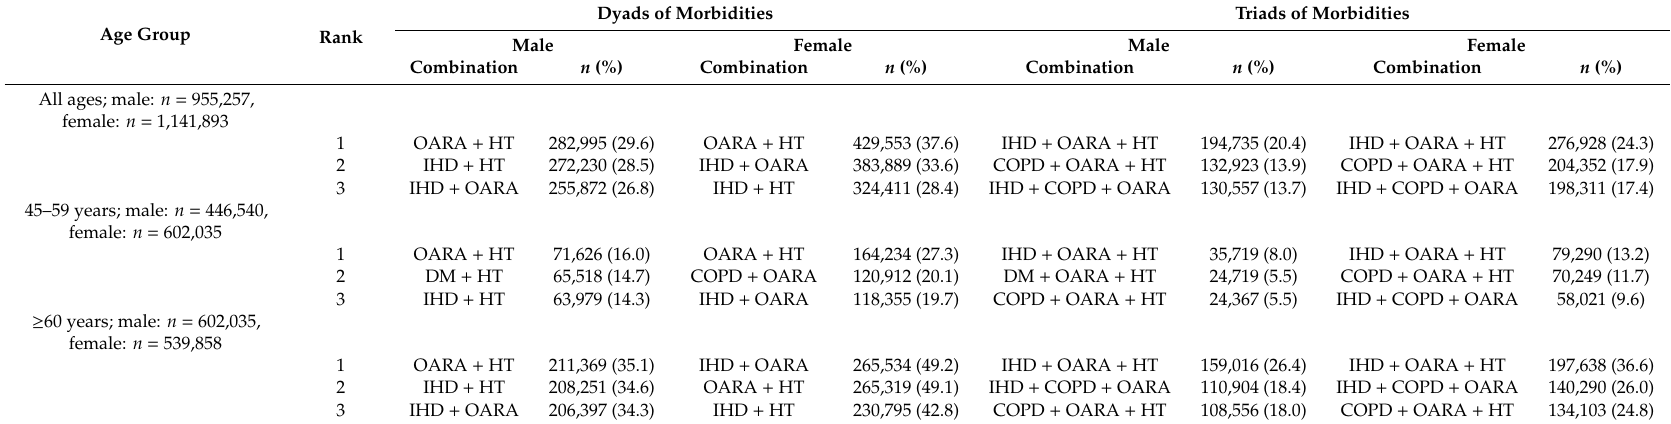
Table 2. Top three frequent unique combination clusters for patients with multimorbidity, stratified by total number of chronic diseases and by sex. Age Group